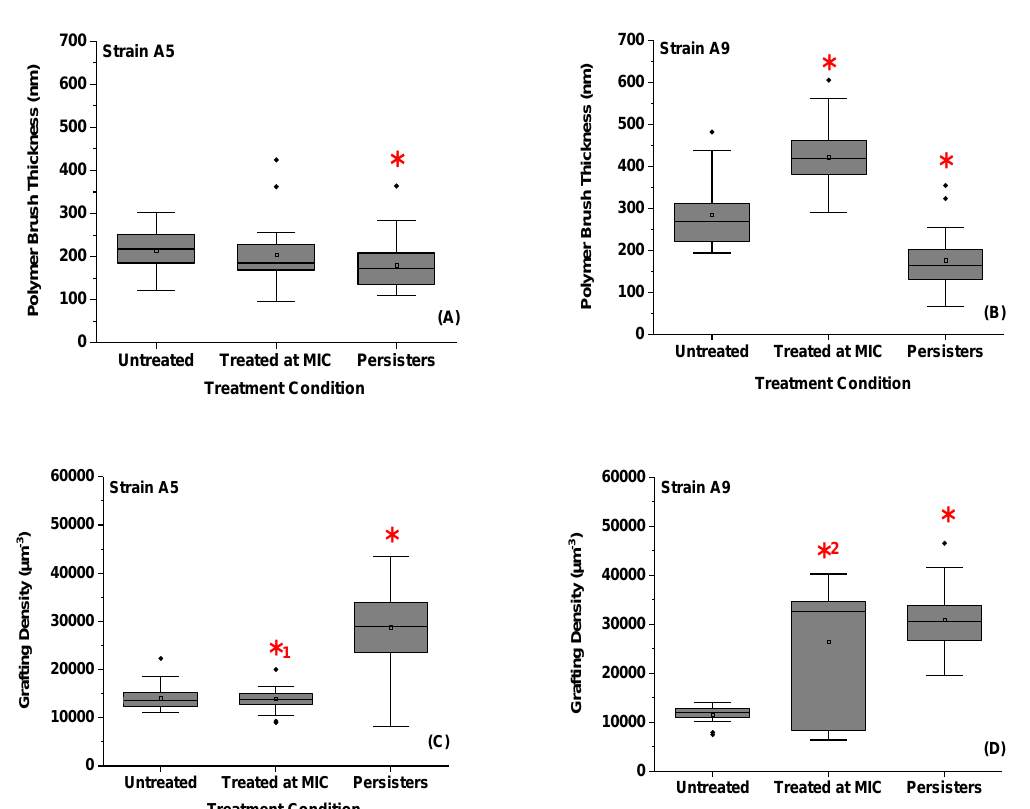
Figure 7. Boxplots showing the distributions of biopolymer brush thicknesses ( A , B ) and grafting densities ( C , D ) of the MDR E. coli Strains estimated using the steric model, Equation (1), or untreated cells, cells treated at MIC, and persister cells, respectively. * Values are statistically significant between the untreated and treated cells. * 1 Values are statistically significant from untreated cells but not from the treated groups and * 2 Values are statistically significant from the treated group but not from the untreated group at p < 0.001, n = 3 independent cultures.